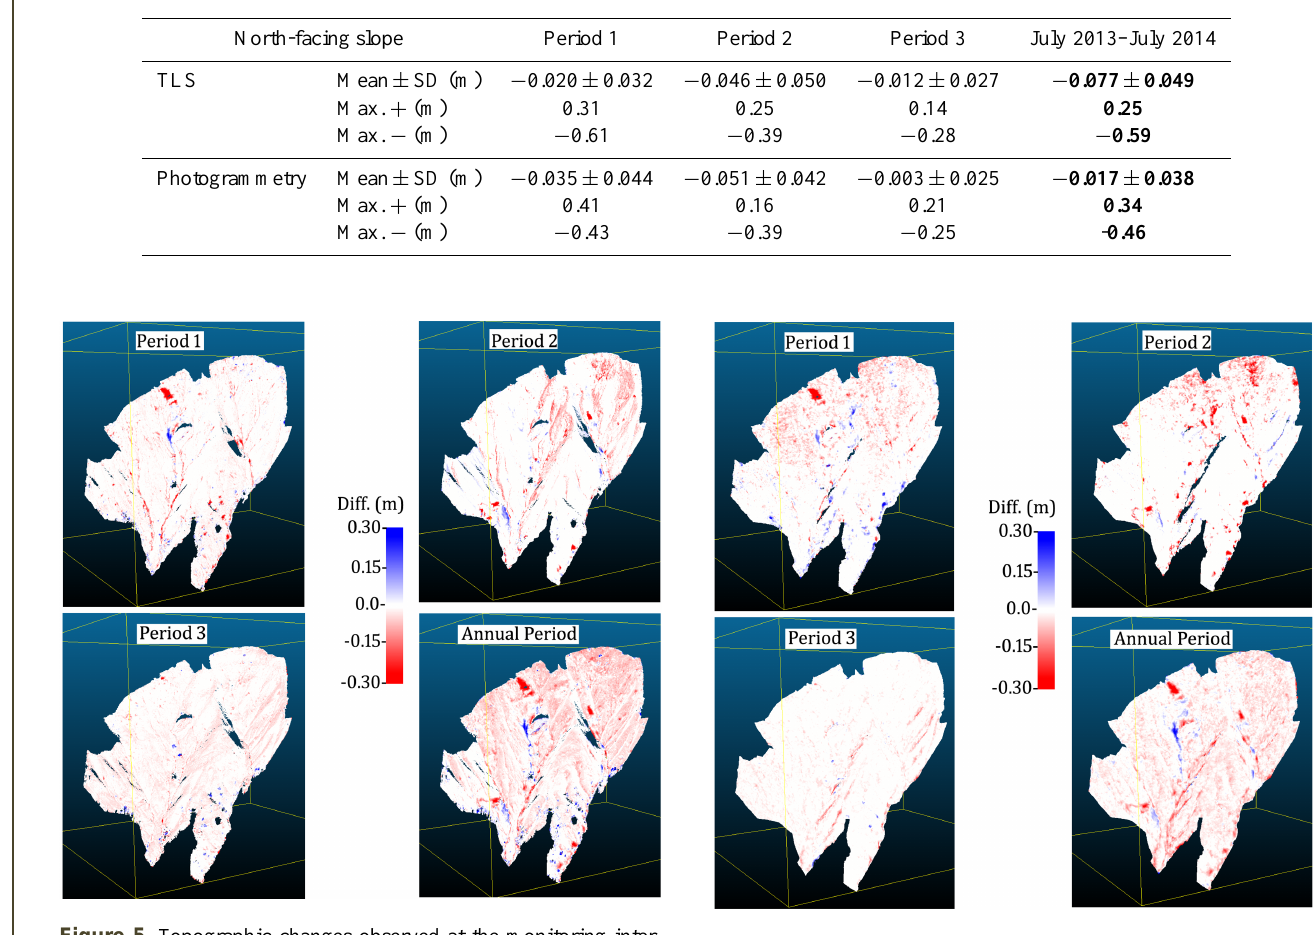
Table 2. Mean differences, standard deviation and maximum differences (Max. + , deposition; Max. − , erosion) of point clouds obtained for different survey periods with TLS and photogrammetry on north-facing slopes. Bold numbers indicate annual values.